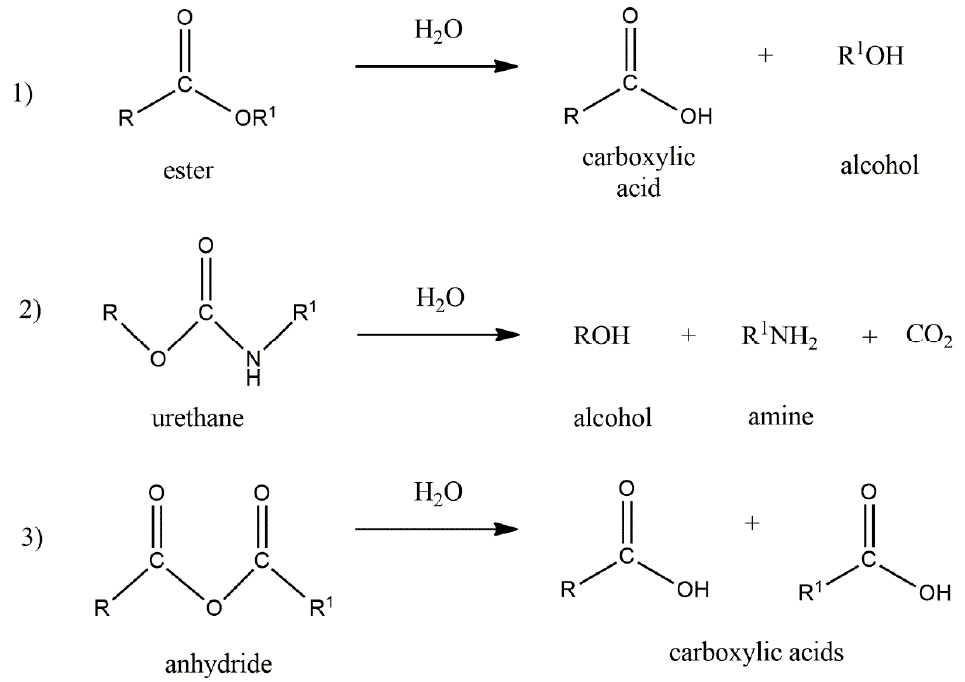
Figure 10. Hydrolytic degradation of ( 1 ) ester, ( 2 ) urethane, ( 3 ) anhydride groups occurring in elastomers.